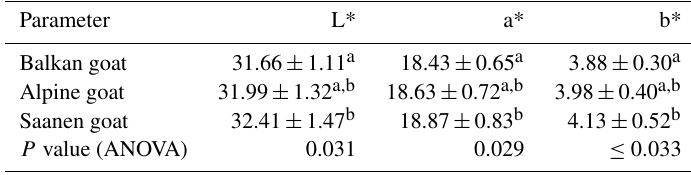
Table 5. Color of fresh goat meat following the CIE L*a*b* system ( n = 40 per breed).